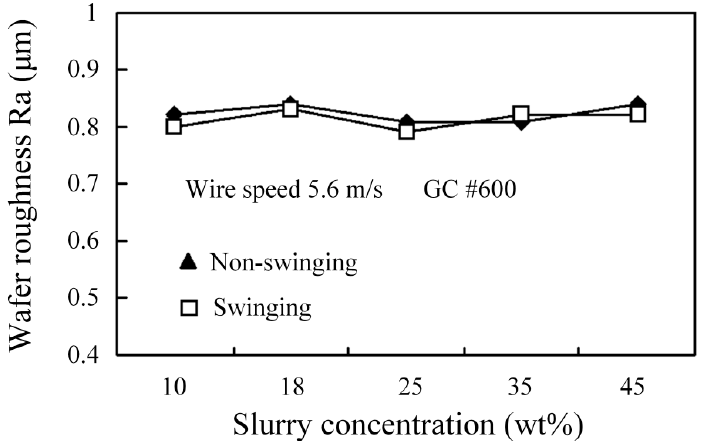
Figure 9. The e ff ect swinging and non-swinging processes on the machined SR for Al 2 O 3 for di ff erent slurry